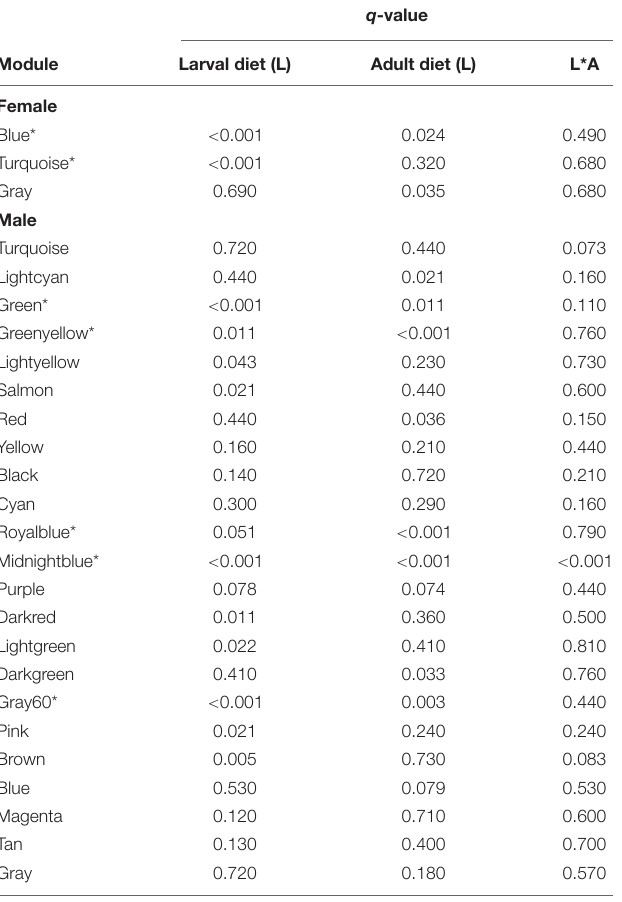
TABLE 1 | q -values for per-module ANOVAs assessing the effect of larval diet (L), adult diet (A), and their interaction (L*A) on module eigengene values. q -value